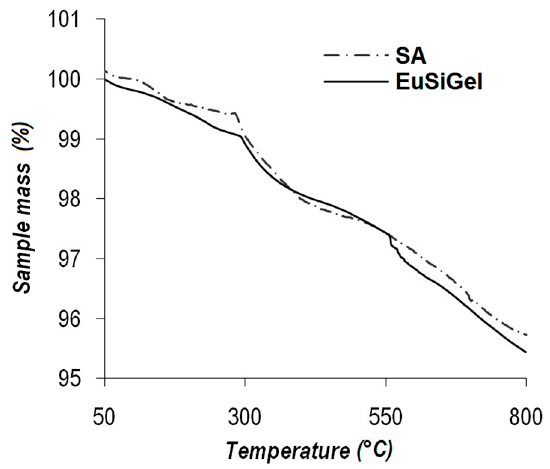
Figure 1. Thermogravimetric analysis of the parent silica aerogel (SA) and the eumelanin-coated hybrid (EuSiGel) in an oxidative environment (air).